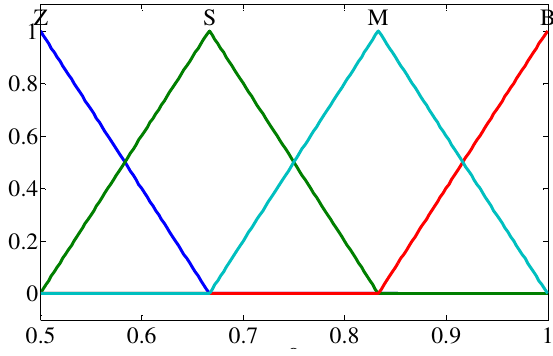
Figure 8. Membership function of expansion factor β.